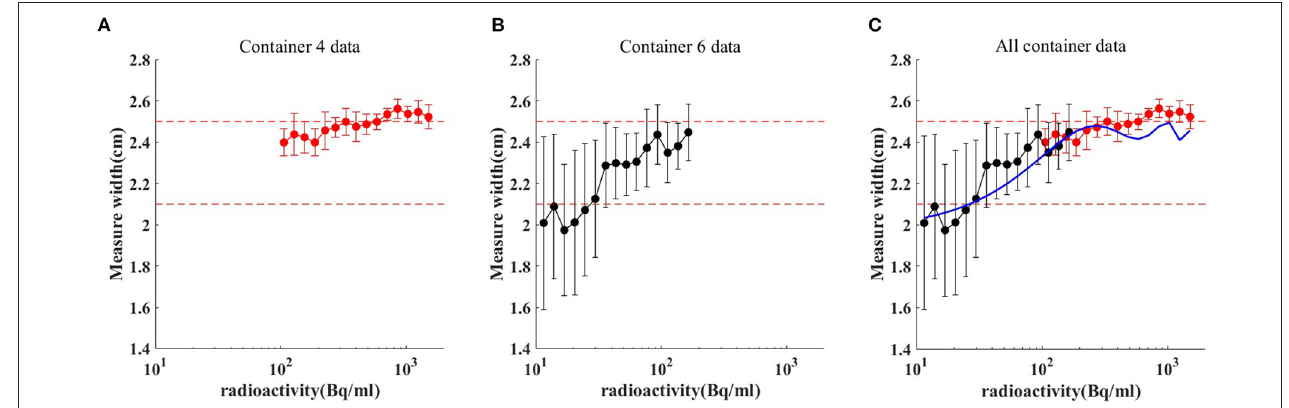
FIGURE 4 | Comparison of container width measured by R50 method (C) with actual. Red dot and red bar represent the mean width and the standard deviation of container 4 (A) , respectively. Black dot and black bar represent the mean width and the standard deviation of container 6 (B) , respectively. When radioactivity between 11.1–111, 111–370, and 370–1,480 Bq/mL, the average width was 2.189 ± 0.253, 2.426 ± 0.09, and 2.521 ± 0.047cm, respectively. The blue line is the radioactivity width error fitted curve for ULA.